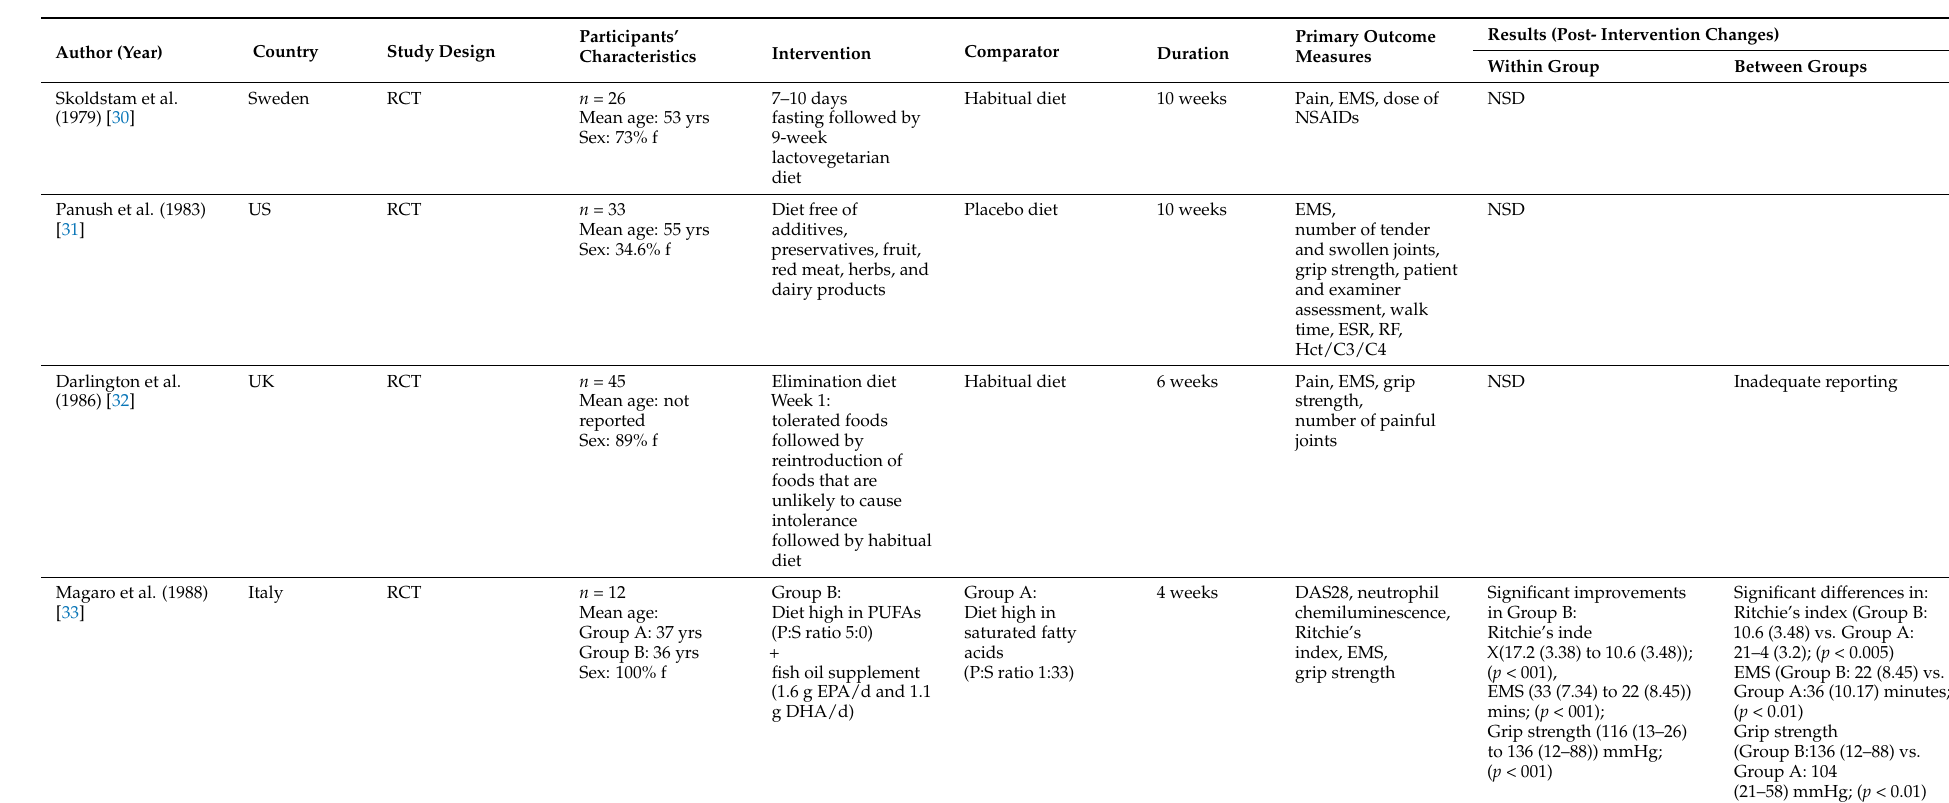
Table 2. Summary of study characteristics for included